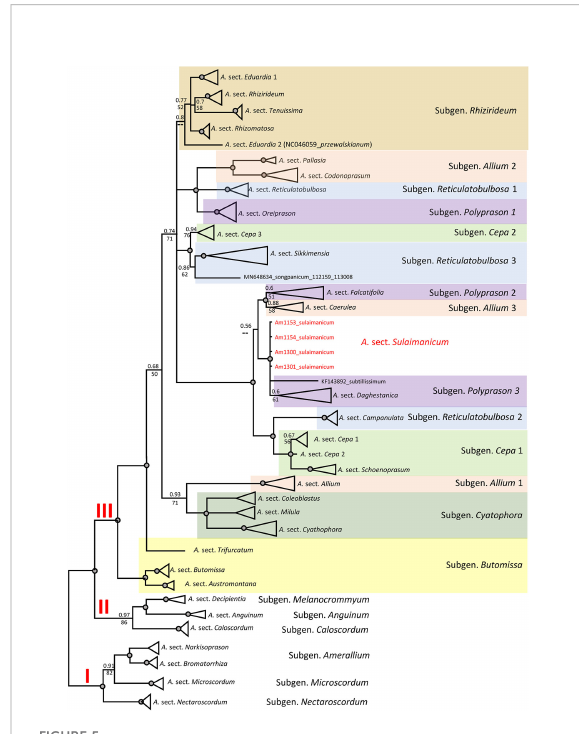
FIGURE 5 Generalised CP tree ( rpl 32- trn L (UAG) intergenic spacer) of the third evolutionary line of genus Allium . Numbers by nodes represent bootstrap support (1,000 replicates) and Bayesian probabilities. Roman numerals (I, II, and III) designate clades of three evolutionary lines. The joint presence of Bayesian probabilities over 0.98 and bootstrap support over 95% is indicated with a black dot.